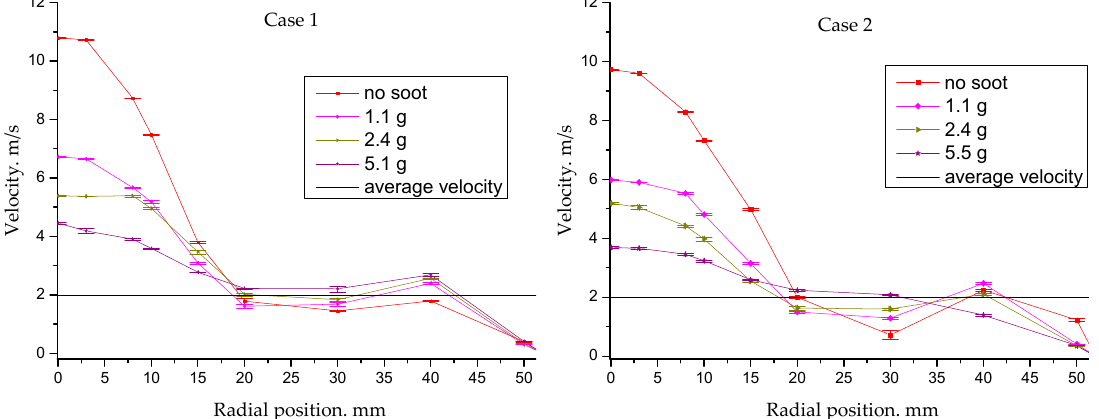
Figure 11. Velocity profiles of case 1 (conventional cone) and case 2 (NURBS cone); the average velocities are 1.98 m/s and 1.99 m/s, respectively.